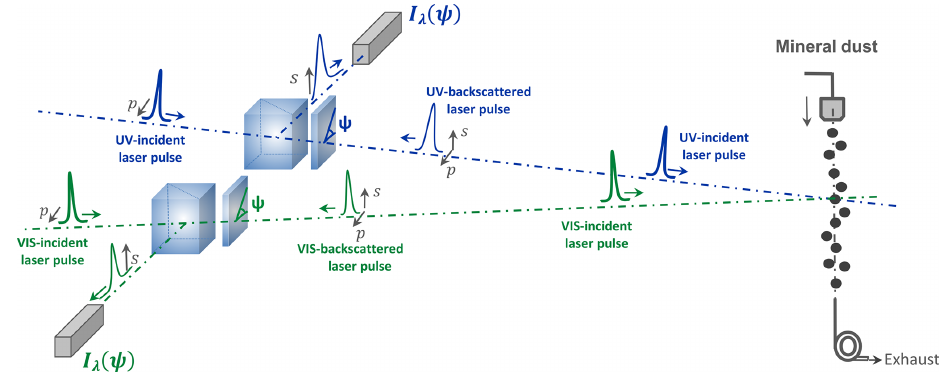
Figure 2. Scheme of the laboratory π -polarimeter operating at lidar exact backscattering angle of ( 180 . 0 ± 0 . 2 ) ◦ , allowing accurate retrievals of the lidar PDR at 355 and 532nm wavelengths simultaneously for an aerosol sample (Miffre et al., 2016). The ( p , s ) polarization com- ponents are defined with respect to the laser scattering plane, and ψ is the angle between the fast axis of the QWP and the laser scattering plane, counted counter-clockwise for an observer looking from the PBC to the particles. The dust lidar PDR is then evaluated from the ratio F 22 ,λ /F 11 ,λ at the specific π angle, following the methodology described in Sect. 3.4.